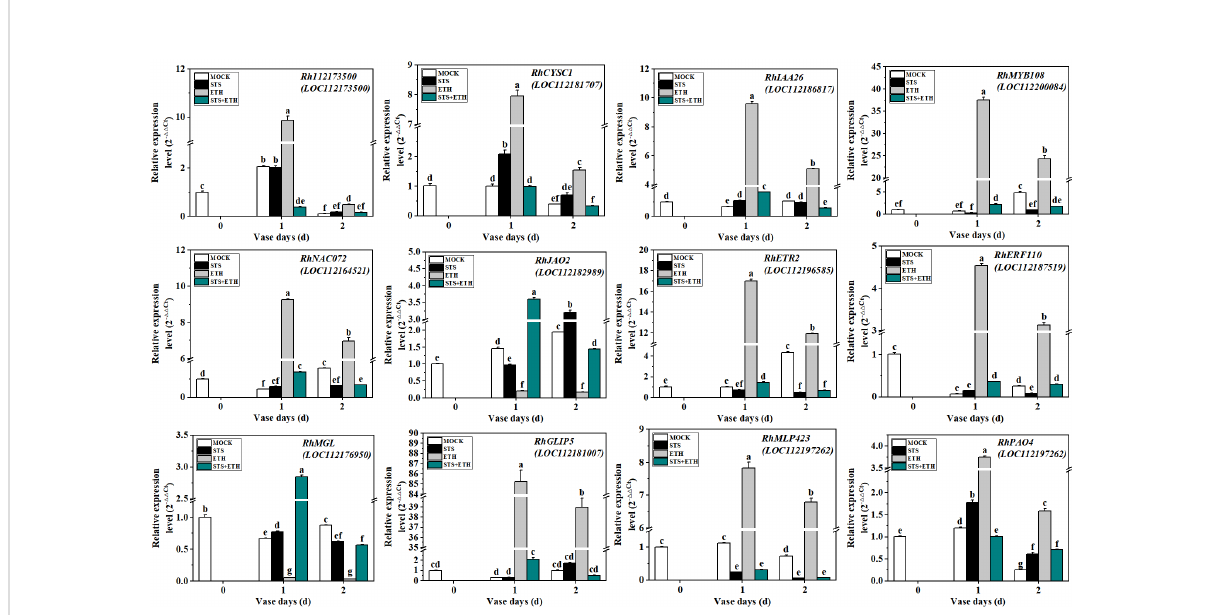
FIGURE 6 Validation of 12 DEGs by qRT-PCR. The experimental method used was 2 - △△ CT^2 . RhUBI2 was used as the internal reference gene. Different letters represent signi fi cant differences based on one-way ANOVA and Duncan's tests (p <